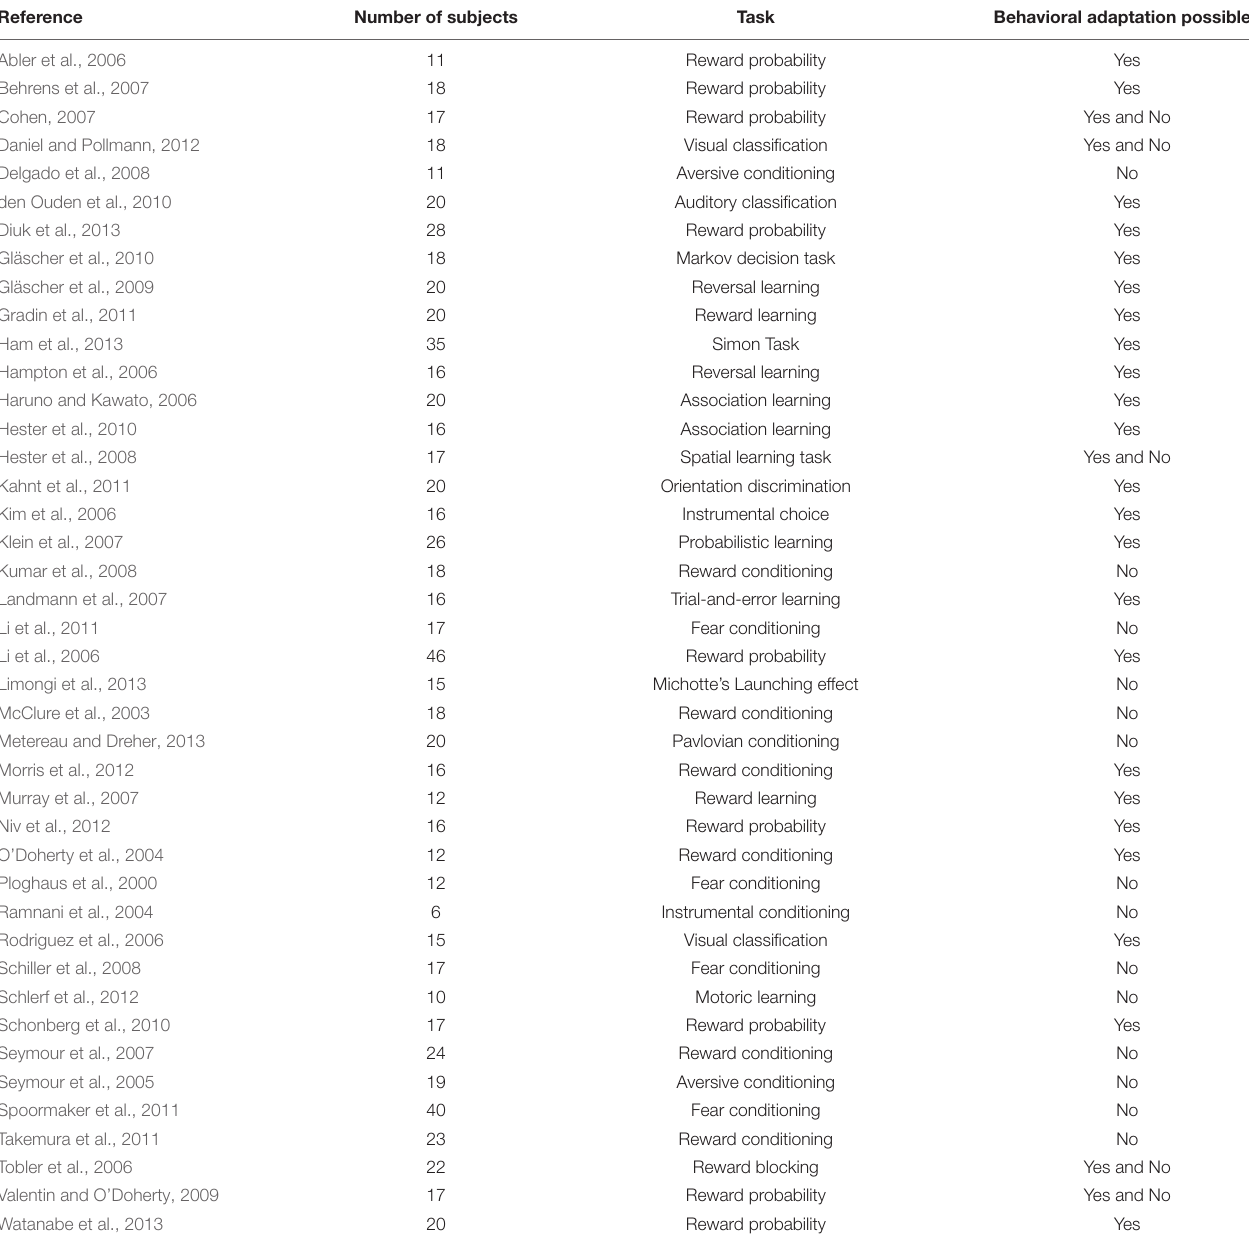
TABLE 1 | Overview of the prediction error studies included in the